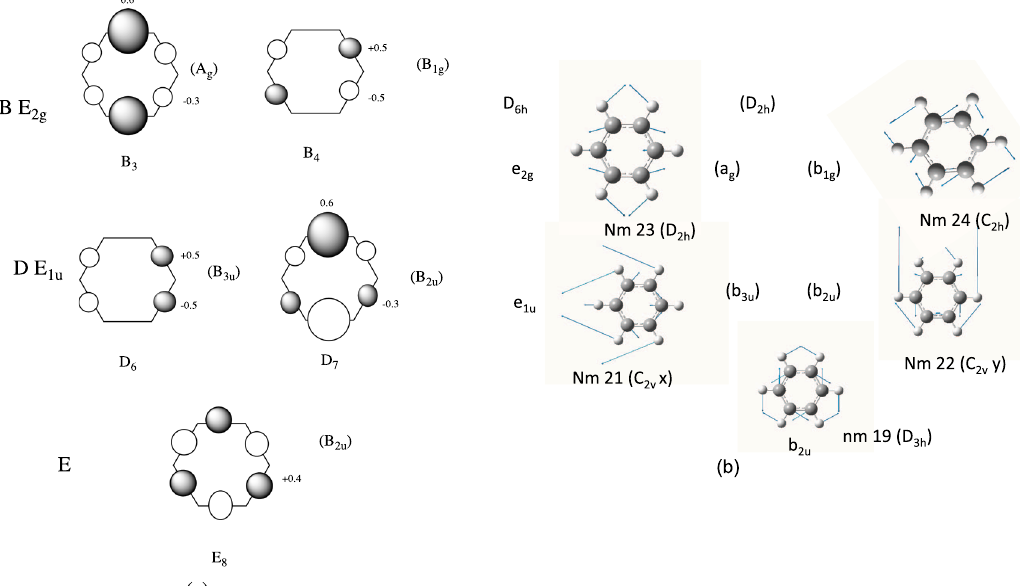
Fig. 2 Reference diabatic states (time 0) and normal modes. a Diabatic states (at time 0) in the permutation representation (Eq. (3)). E D B are spectroscopic notation (the π states are shown with orbital plots in SI), E 1 u , E 2 g , etc. refer to D 6 h symmetry while the additional labels in brackets ( B 2 u ) … . refer to D 2 h symmetry. Each shaded lobe represents a positive contribution while an unshaded lobe is negative. The coef fi cient for each lobe is from Eq. (3). b Computed normal modes spanned by the same permutation representation. They are ordered from lowest energy to highest. The nature of the symmetry lowering for each normal mode is indicated in parenthesis. The couplings of the electronic states and normal modes are indicated in Table 1 and Supplementary Note 4 and Figure